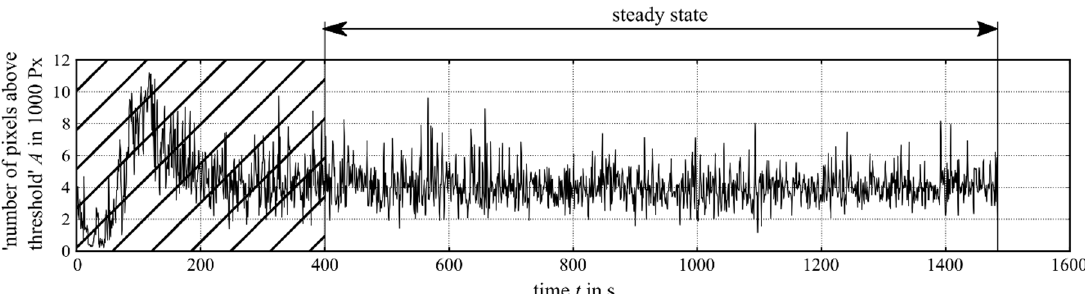
Figure 5. The number of pixels (NOP) within the ROI above a threshold of 948 digits calculated for a whole cylinder build-up. The first quarter of the signal was not considered for the calculations because of its transient behaviour caused by the heat-up dynamics. The graph shows the experiment at P = 2000 W.